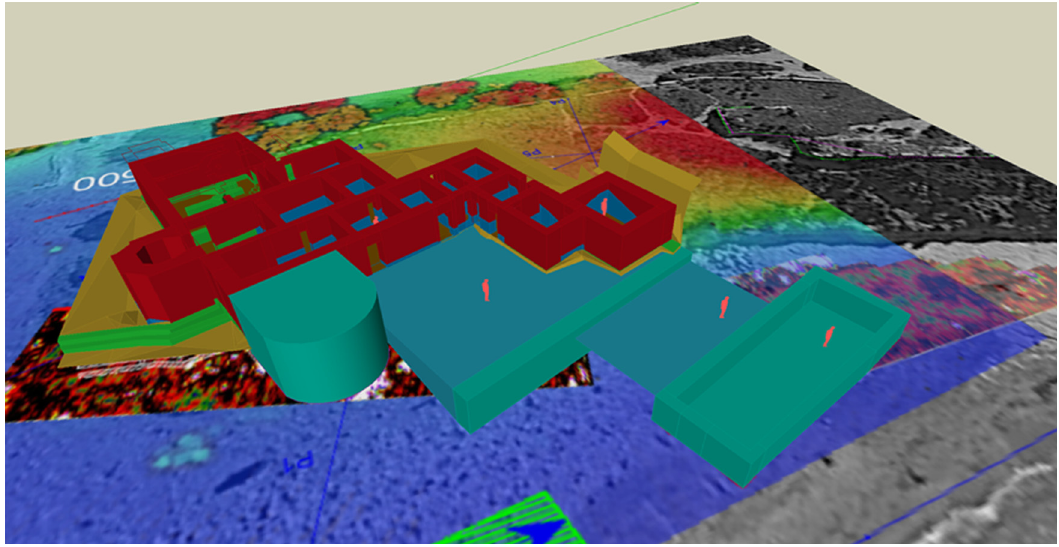
Figure 12: The process of creating 3D digital reconstruction on the new plan produced after the